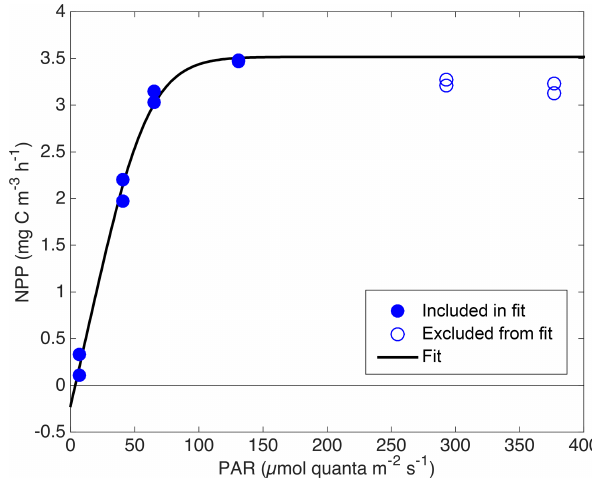
Figure 5. Example NPP vs. PAR relationship from 14 C incubations, with best-fit “PvE”